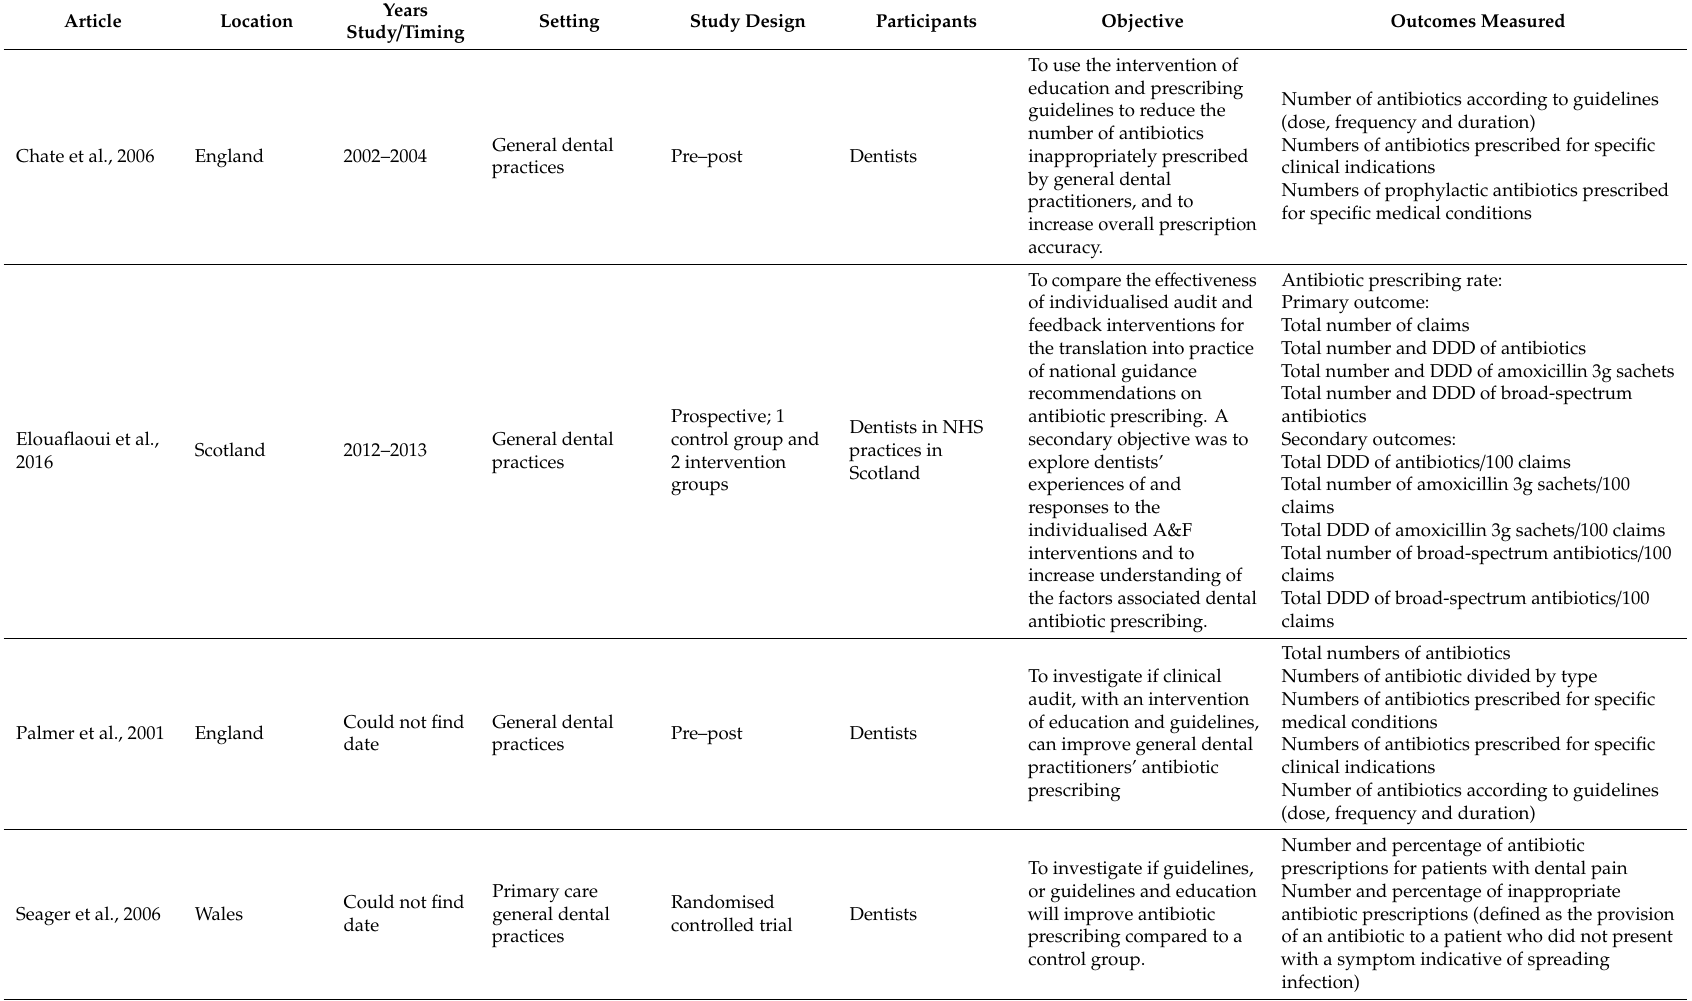
Table 2. Characteristics of included studies in the systematic review across primary dental